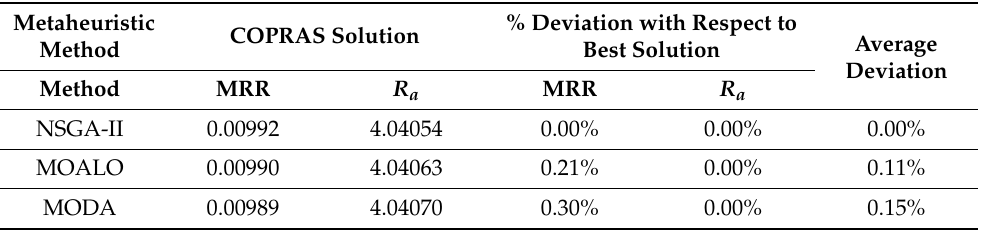
Table 6. Deviation in solutions of different metaheuristics as compared to the COPRAS best solution (Example 2, 700 µ m slot).